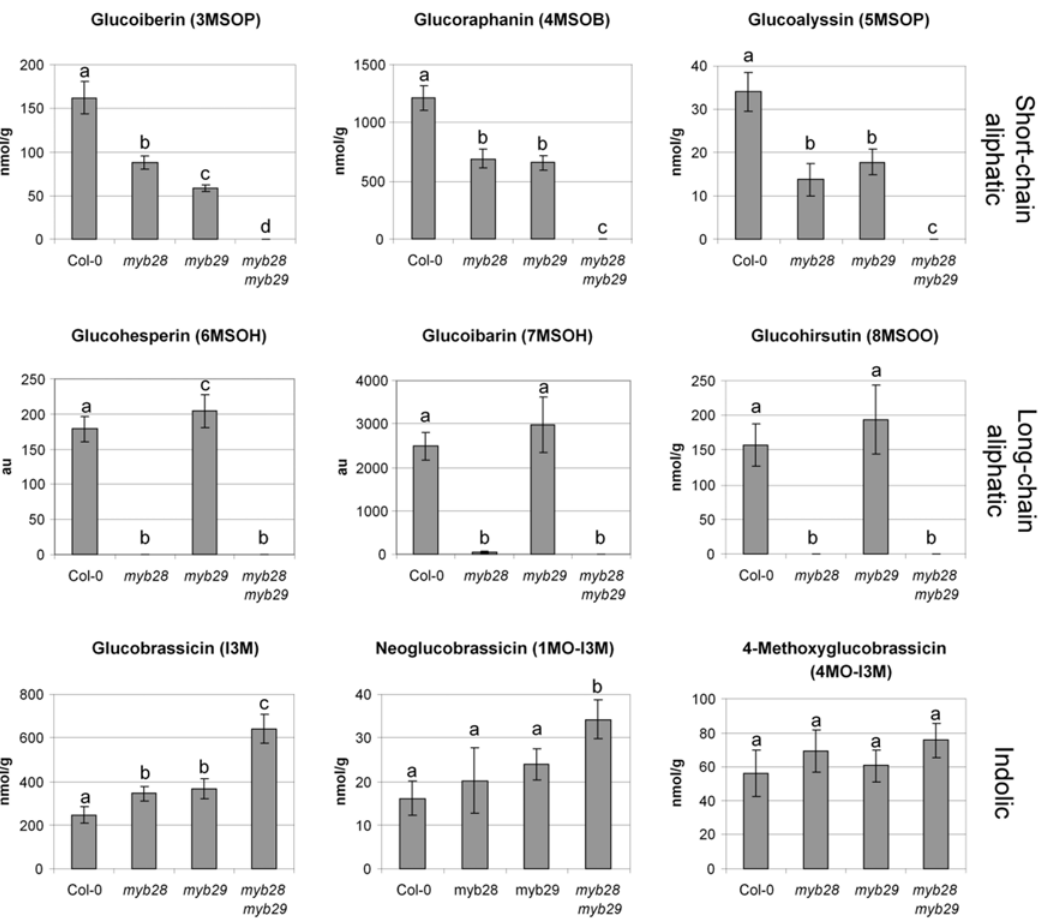
Figure 5. Concentration of individual glucosinolates in leaves from different Arabidopsis genotypes. Error bars indicate standard deviations (n=5). Characters on the error bars indicate significance groups (p , 0.05, Tukey post hoc test). All values were determined as nmol per g fresh weight, except for glucoibarin and glucohesperin. The latter compounds were below the detection limit in the dedicated HPLC analysis, but could be analyzed from the LC-MS analysis. Therefore they are represented as ion counts (arbitrary units; a.u.).